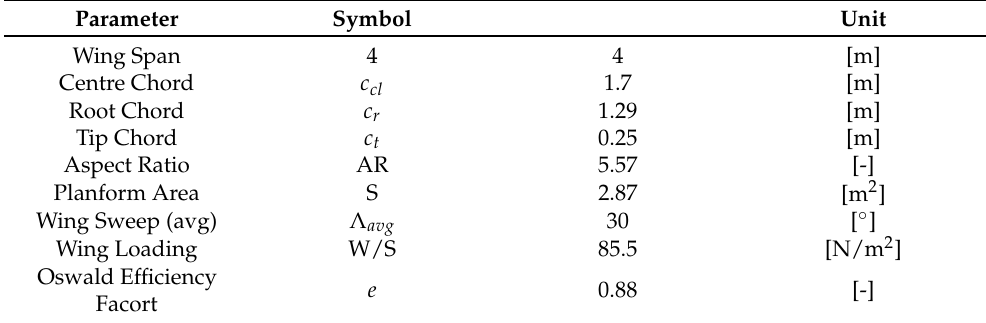
Table 7. Aircraft